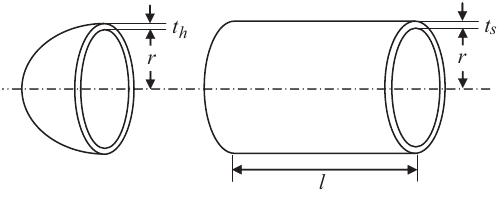
Figure 3. Configuration of a pressure